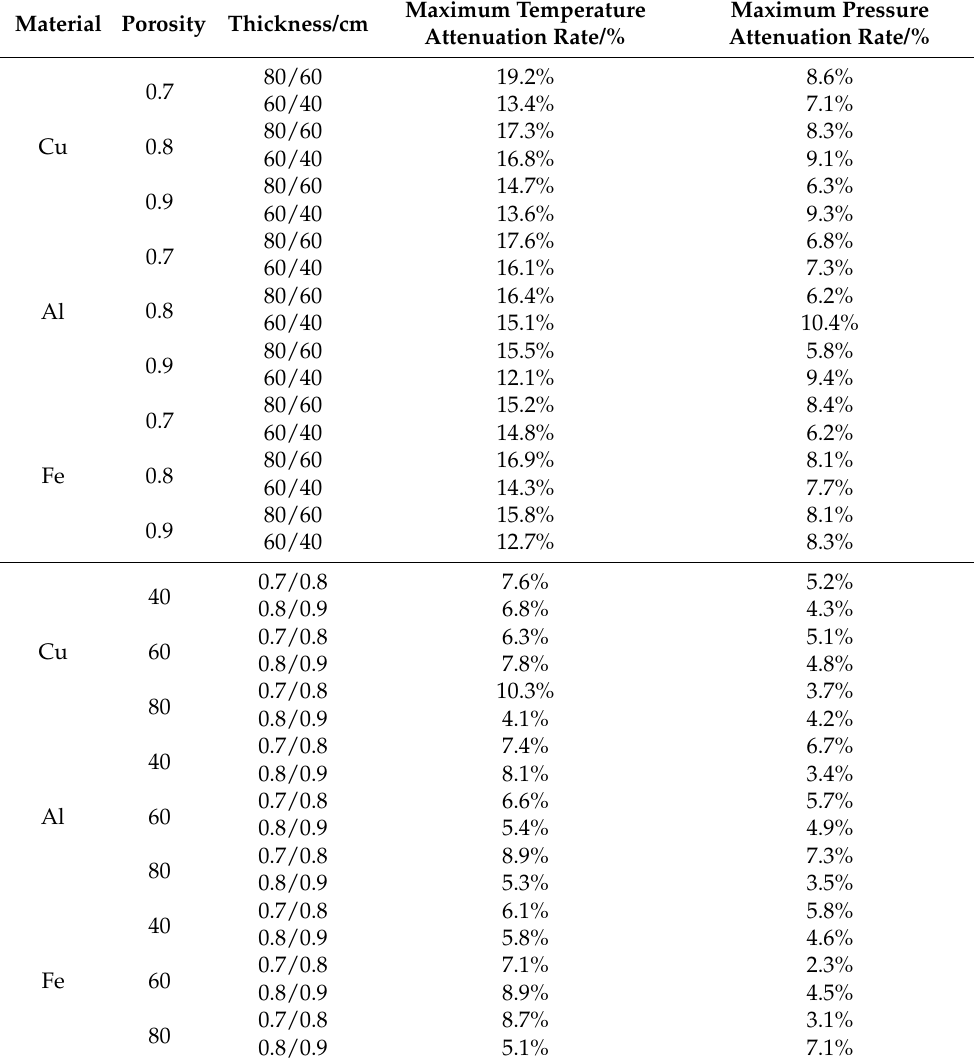
Table 2. Influence of material, porosity, and thickness of metal foam on propagation of maximum temperature attenuation rate and maximum pressure attenuation